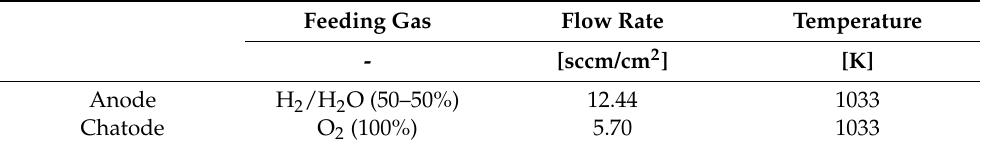
Table 3. Feeding condition for the experimental fuel cell